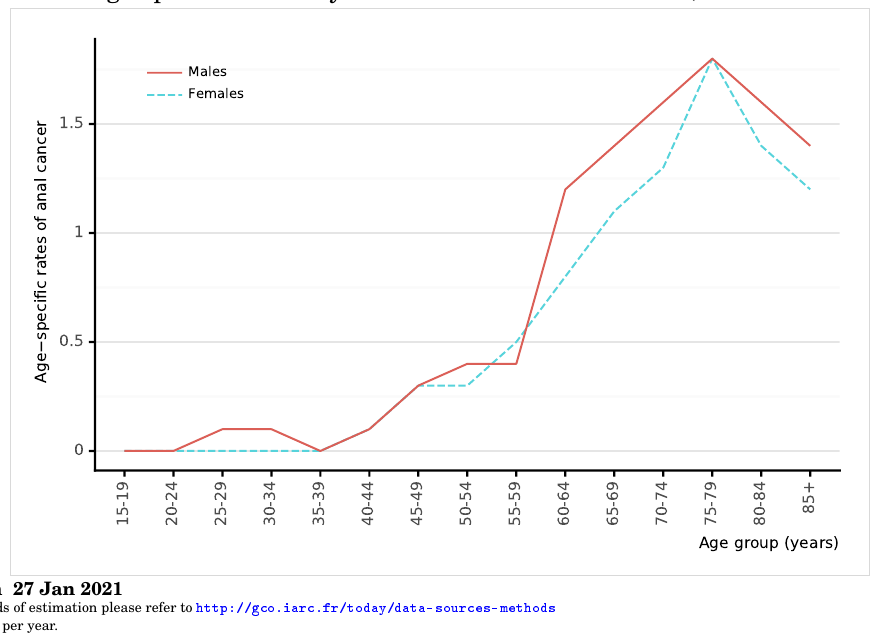
Figure 17: Age-specific mortality rates of anal cancer in India (estimates for 2020)